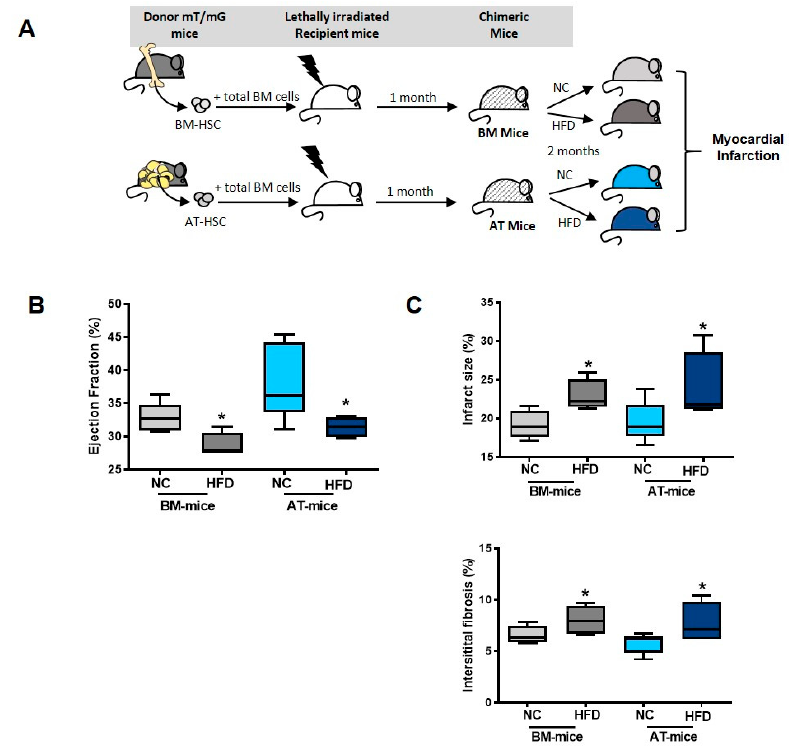
Figure 5 High Fat Diet worsens cardiac remodeling and function. ( A ) Schematic representation of experimental procedure: lethally irradiated recipient mice were co-injected with hematopoietic stem cells (HSC) sorted from sub-cutaneous adipose tissue (AT) or bone marrow (BM) and total BM cells isolated from mT/mG donor and C57Bl6 donor mice, respectively. Eight weeks after reconstitution, mice were then fed a normal Chow (NC) or a high fat diet (HFD) for 2 months. ( B ) Ejection fraction and ( C ) infarct size as well as interstitial fibrosis in BM- and AT- mice fed a normal Chow (NC) or a high fat diet (HFD) for 2 months and then challenged with MI (n = 4–10). Comparisons between groups were performed using Dunn’s multiple comparisons test.* p < 0.05 in HFD vs NC fed mice.